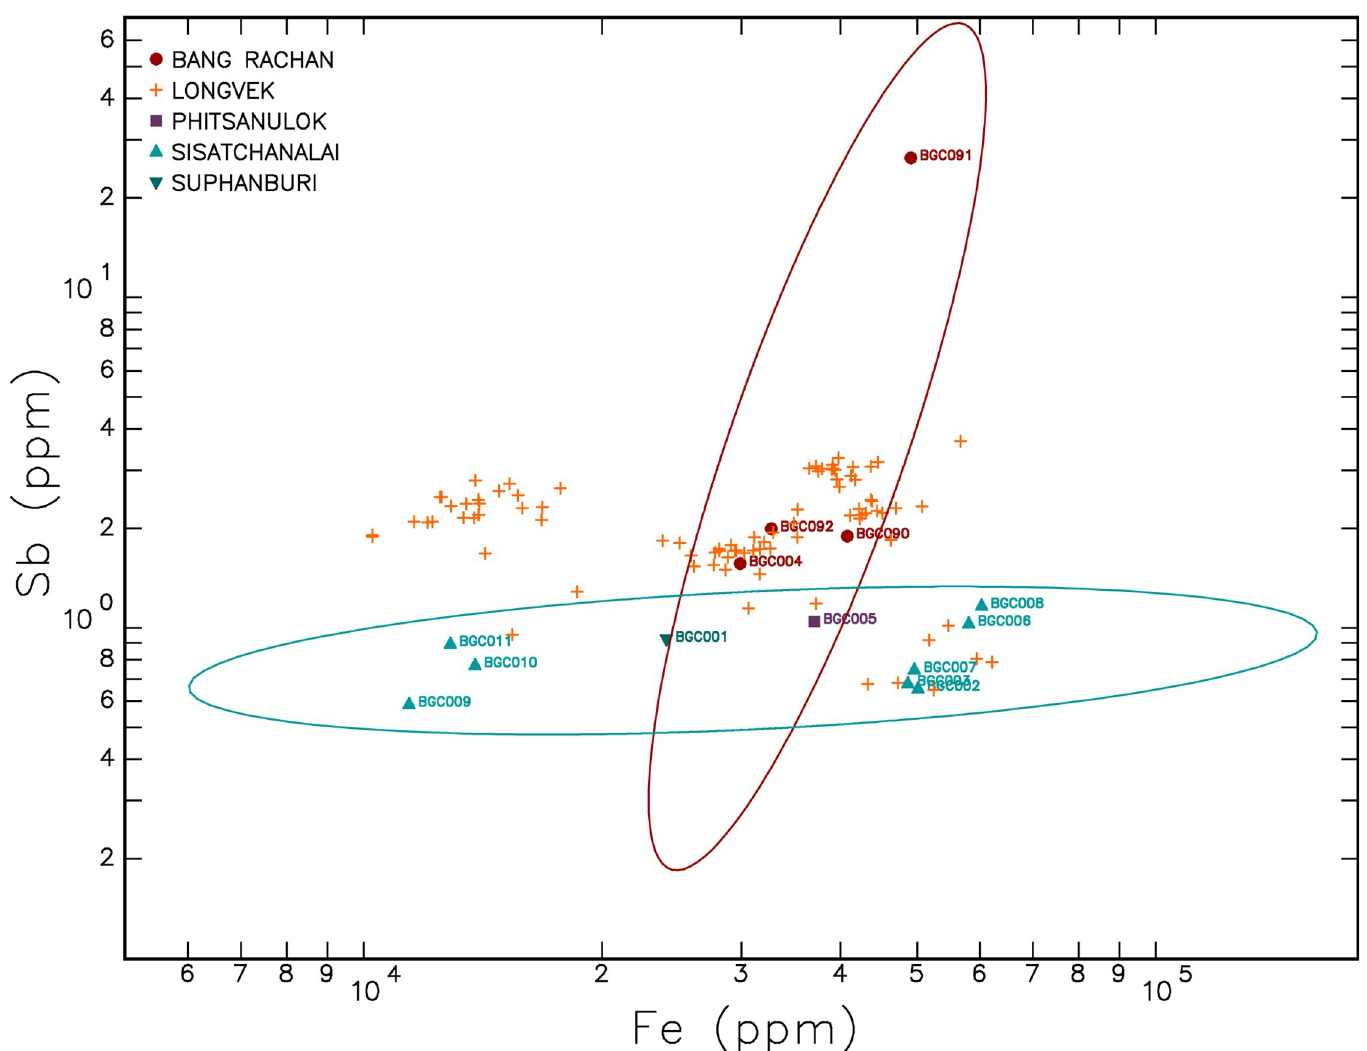
Fig 5. Bivariate plot of Fe and Sb concentrations with emphasis on Bang Rachan and